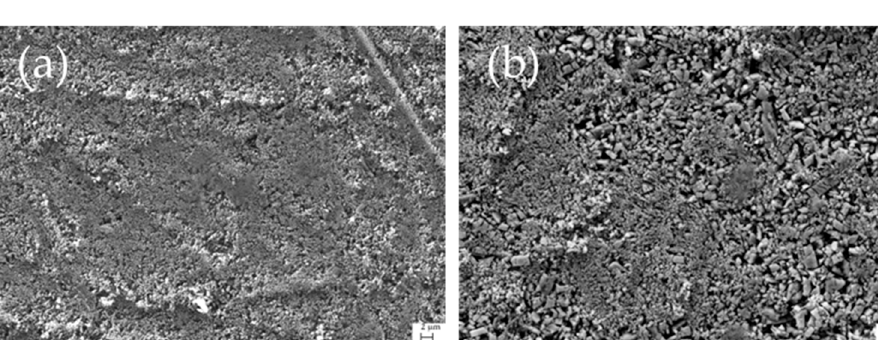
Figure 1. SEM microphotographs taken by backscattered electrons on the surface of pellets of sample ( a ) NdDy20 and ( b ) NdDy60. ( a ) NdDy20 and ( b )